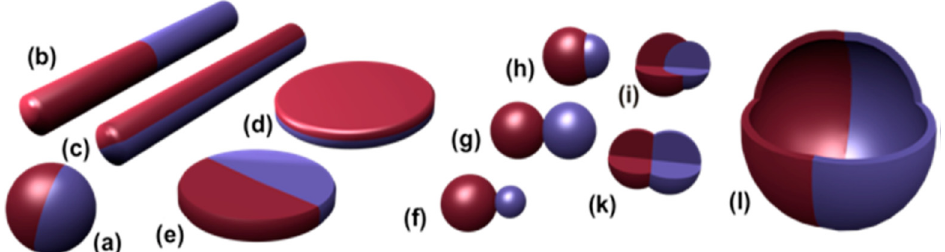
Figure 2. Description of Janus particles in different shapes. ( a ) Spherical. ( b , c ) Two different types of cylindrical. ( d , e ) Two different types of disc-shaped Janus. ( f ) Snowman character. ( g , k ) Symmetric appearance. ( h ) Attached nodes. ( i ) Eccentric encapsulation. ( l ) Janus vesicles or capsules [60].